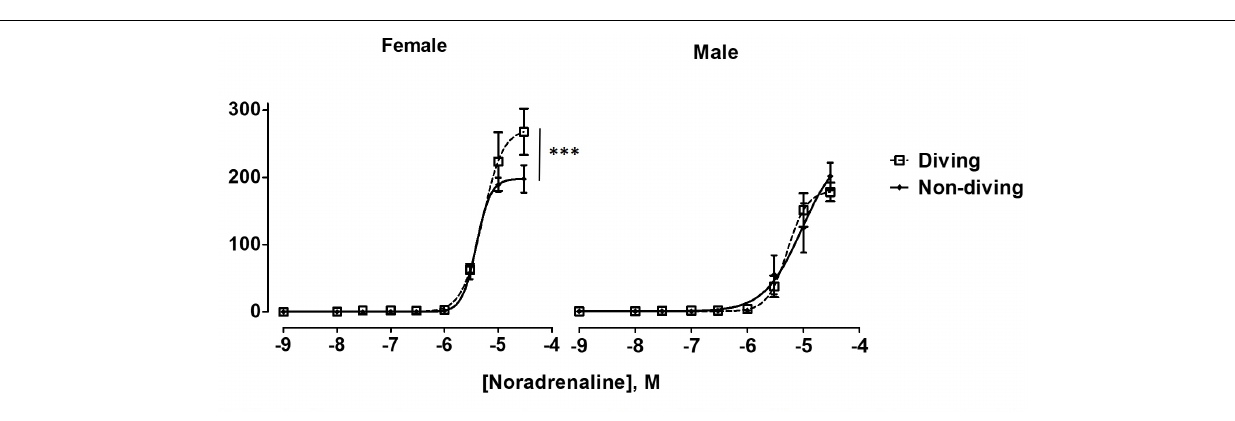
FIGURE 6 | Noradrenaline concentration-response curves of mesentery arteries in ApoE KO rats from different experimental groups under control condition. To fit the experimental data to non-linear regression curves, noradrenaline concentration of 3 × 10 − 5 M was assumed to induce maximal contractile response in non-diving male rats. ∗∗∗ P < 0.001, diving vs. non-diving female rats, F test, n =